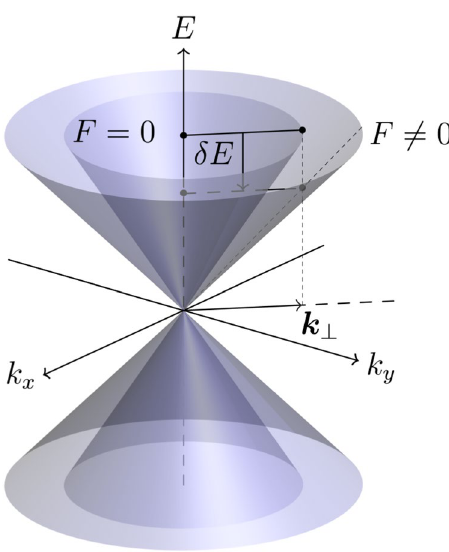
Figure 2. Dirac cones of the surface states at zero and finite electric field F , applied perpendicular to the interface. When the electric field is adiabatically switched on, the magnitude of the electron energy decreases by an amount δ E and the conservation of the interface momentum, k ⊥ , gives rise to a widened